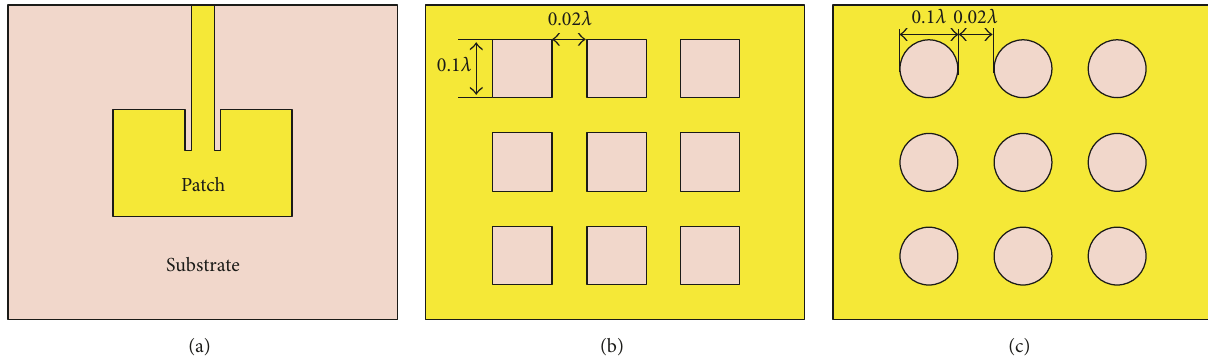
Figure 4: Schematic diagram of (a) patch antenna with EBG; (b) geometry of rectangular EBG; (c) geometry of circular EBG.